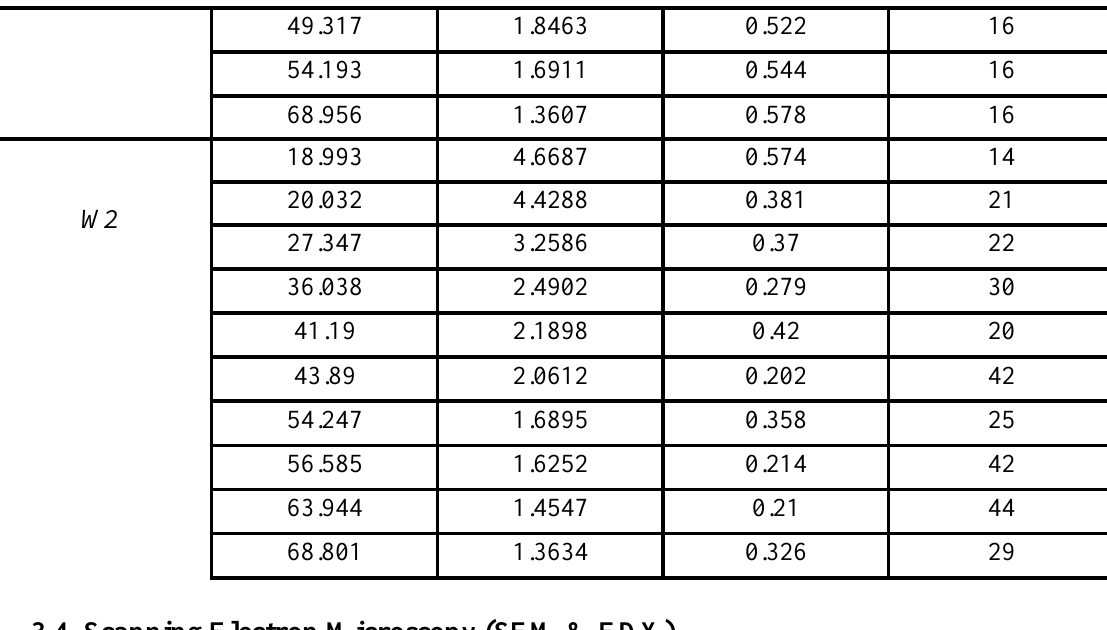
Figure 5: SEM images and DEX of (a)pure PANI (H) (b) PANI/TiO prepared by chemical